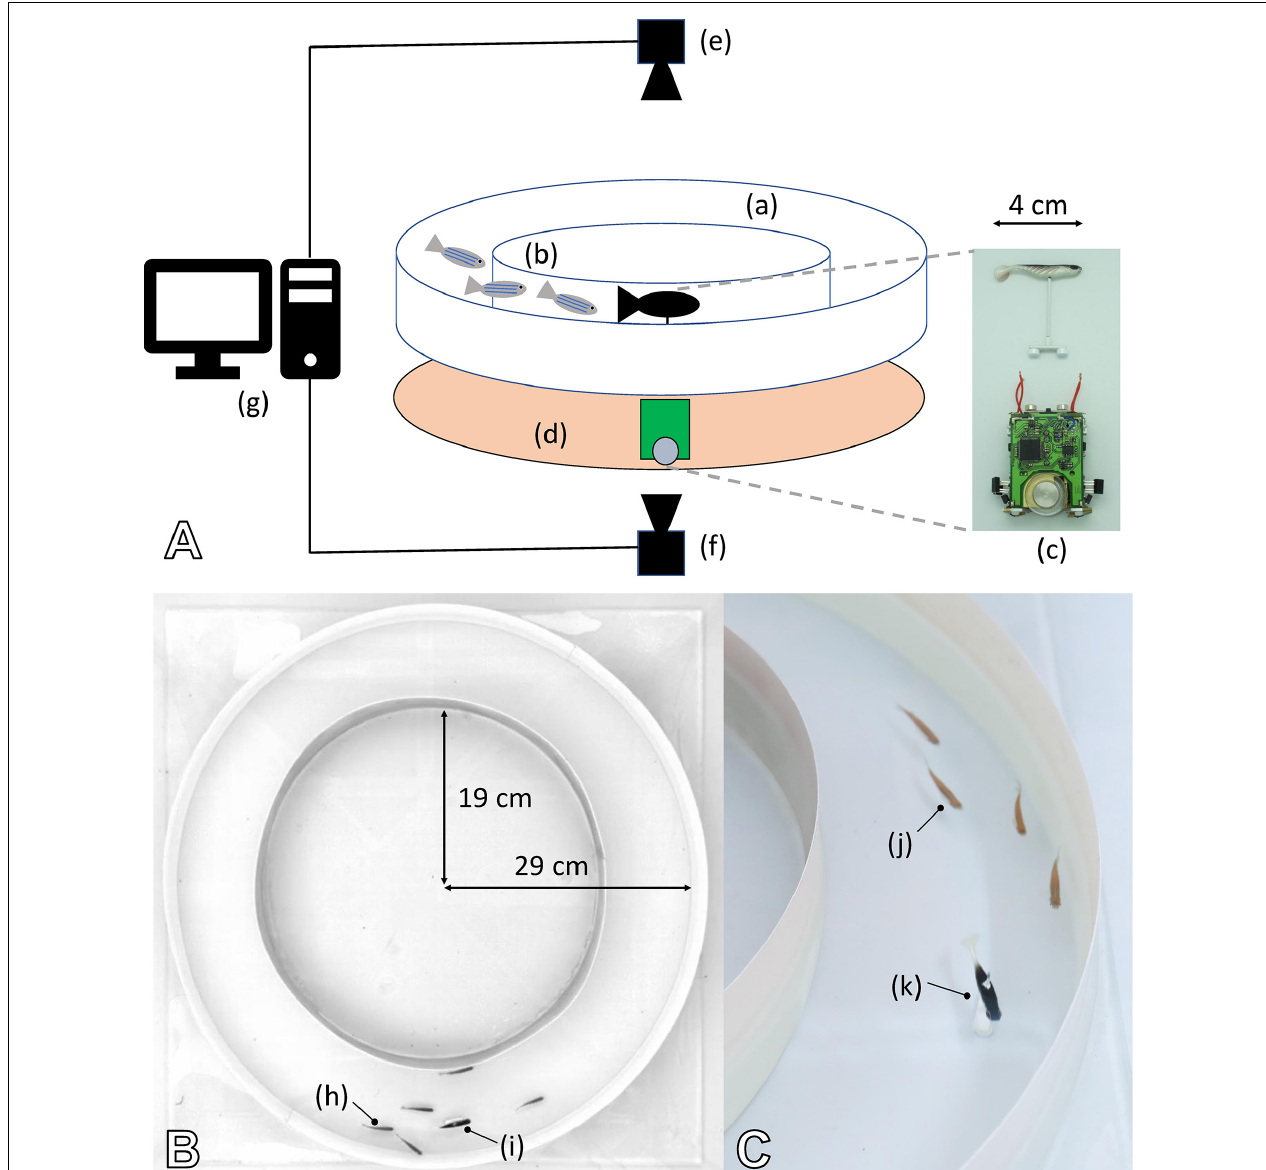
FIGURE 9 | Experimental set-up created to study the interactions in mixed groups composed of fish and one or multiple robots. (A) (a) Experimental arena composed of two circular walls forming a circular corridor to condition the behaviour of the agents (see also B ). (b) Zebrafish moving inside the corridor. (c) The fish robot is composed of a miniature mobile robot (FishBot) and a lure, which is magnetically coupled with the FishBot. (d) Support in which the FishBots are moving, which provides the powering of the system for long-duration experiments. (e) Top camera, which captures the images that are used to determine the position of the agents in real time. (f) Bottom camera, which captures the images to determine the position of the FishBot. (g) Computer running the CATS software for tracking and closed-loop control of the robots in real time. (B,C) The arena is composed of two circular walls of 19- and 29-cm radius, which forms a circular corridor of 10-cm width in which the zebrafish (h,j) can move with the robot (i,k). With this configuration, the zebrafish shoal in either the CW or CCW direction, and we can use one or several bio-mimetic robots to blend in with the shoal and influence the swimming direction. (B) The top view from the top camera that is used to process the positions of the